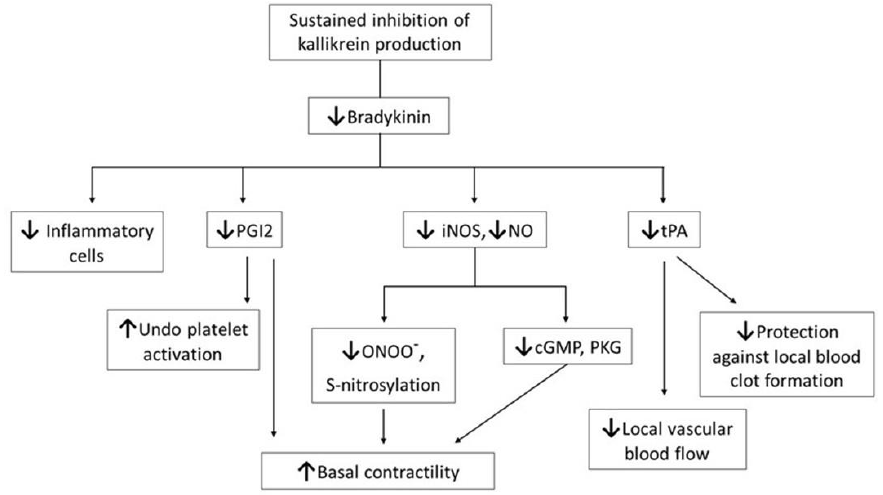
Figure 1. Schematic presentation showing that the inhibition of the plasma kallikrein – kinin